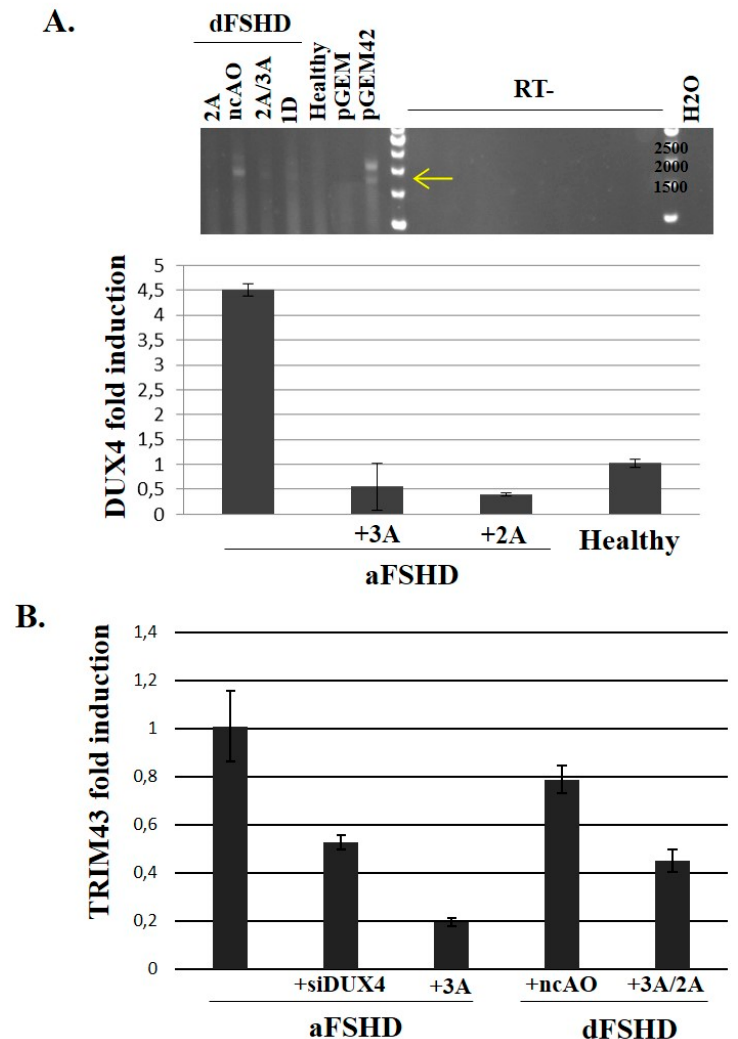
Figure 5. Evaluation of DUX4 ‐ AO efficiency on endogenous DUX4 and target mRNA expression